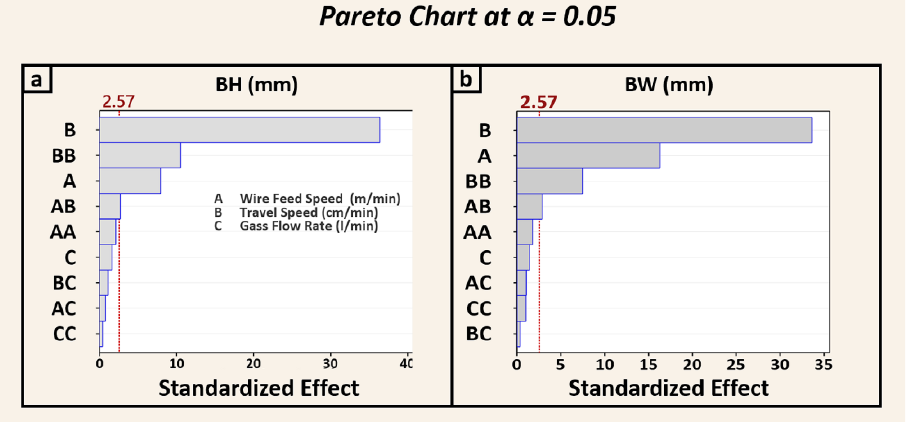
Figure 7. The Pareto effect chart, employed to analyze the significant effect of different process var- iables on the ( a ) BH and ( b ) BW developed using the RSM approach. variables on the ( a ) BH and ( b ) BW developed using the RSM